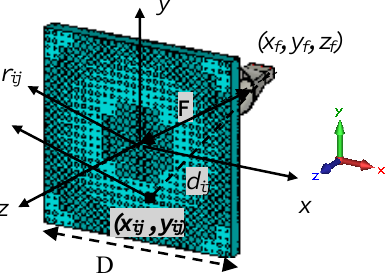
Figure 1: (a) Transmitarray unit-cell element design at 10 GHz. (b) The variations of the transmitted phase and magnitude with hole radius at 10 GHz.